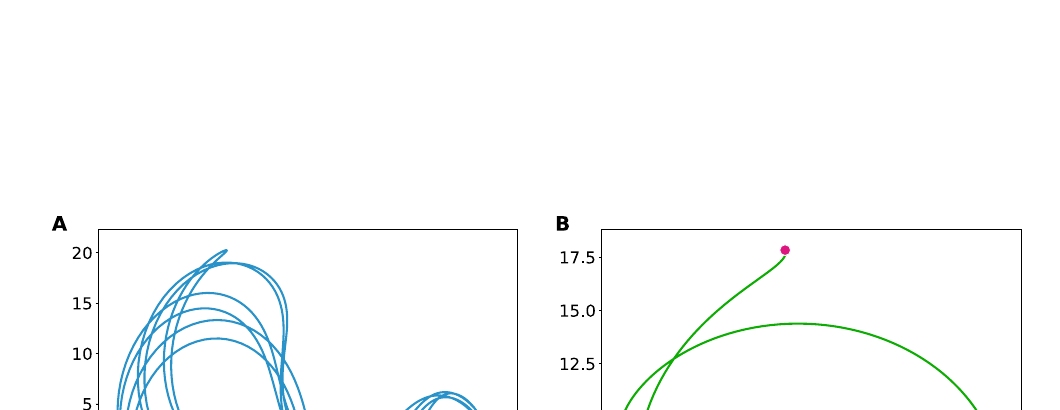
Figure 1. Strutt diagram of a biharmonic field (Eq. 12). The stability regions, areas, whereas the instability regions, with the aid of the matrix entries h 11 or h 21 . If both entries are simultaneously equal to zero we have a pure squeezing effect, otherwise, the squeezing operations can be generated by taking the points inside the coloured areas. That is the case of the tracked subregions of amplitudes that would achieve the effects of h 11 (cid:31) 4 . A point (β 1 , β 2 ) lying in the clear areas could be used to produce a class of stable motion, showing h 11 = = a loop effect, such as the required for ion traps.